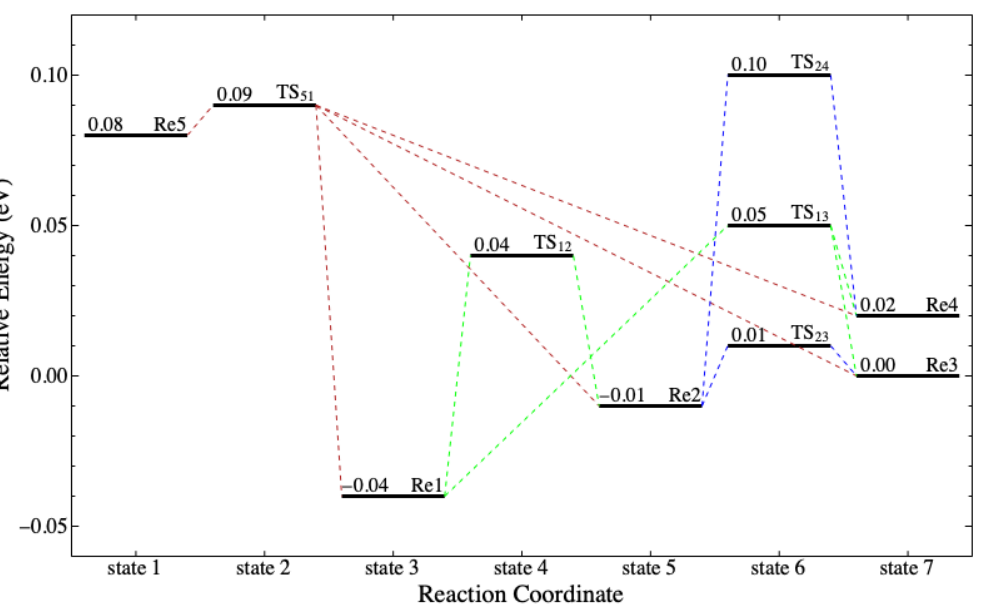
Figure 7. The reaction coordinates for all potential reactants in Table 7 before forming the activated complex (TS-a, TS-b, TS-c, and TS-d): TS 12 means the transition state of conformational isomerization from Re1 to Re2.